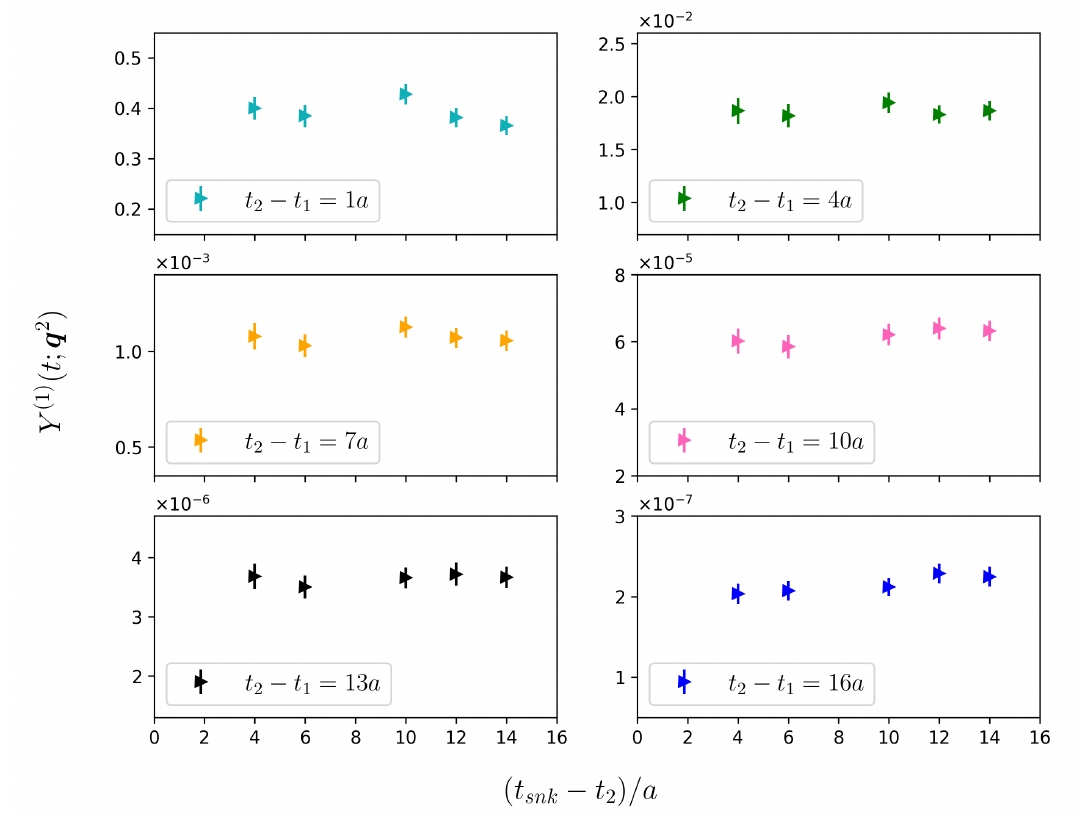
Figure 7 . Correlator Y (1) ( t, q 2 ) at various time separations t 2 − t 1 for | q | ’ 0 . 5 GeV. The points in each subplot are obtained for different values of t 2 , with the x -axis showing the distance between t snk and the time t 2 at which the current is